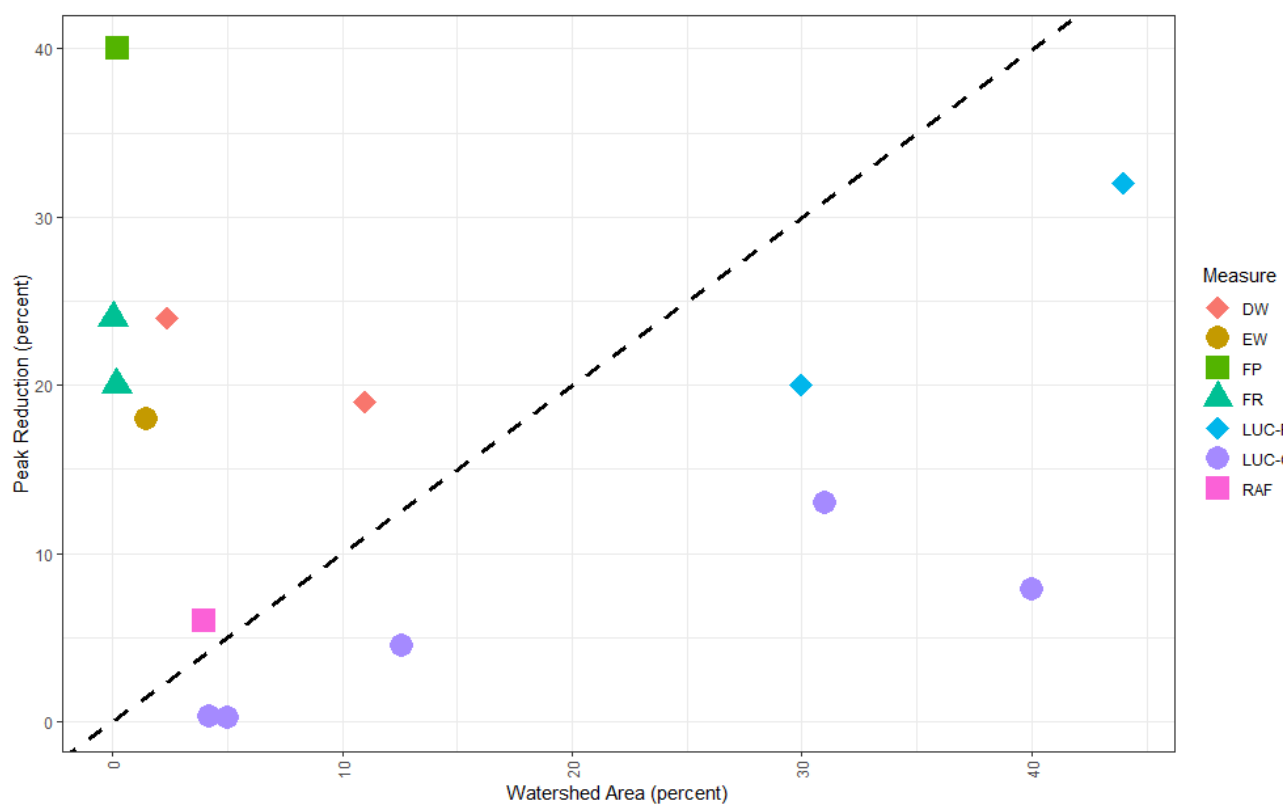
Figure 3. Areal extent of natural infrastructure measures as a proportion of the watershed in which they are placed (x-axis) in relation to the reduction in peak flows (y-axis). DW = depressional wetlands, EW = engineered wetlands, FP = farm ponds, FR = floodplain restoration, LUC-F = conversion of cropland to native vegetation—forest, LUC-G conversion of cropland to native vegetation—grasses, RAF = runoff attenuation features. The dashed black line represents a 1:1 relationship between areal extent and flood reduction.